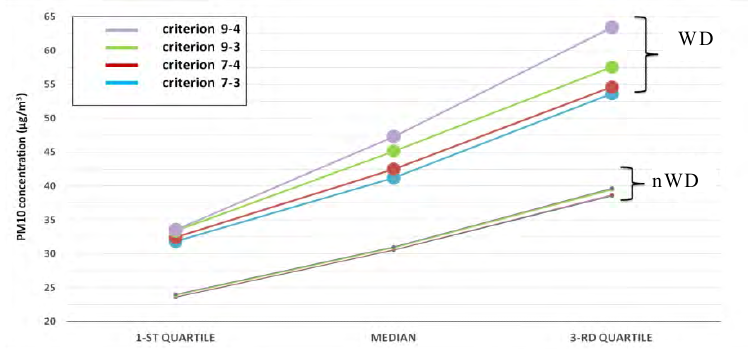
Fig. 3: 1st and 3rd quartiles and median values of Tamburi PM10 distributions obtained from WD and nWD classes for each selected criterion.